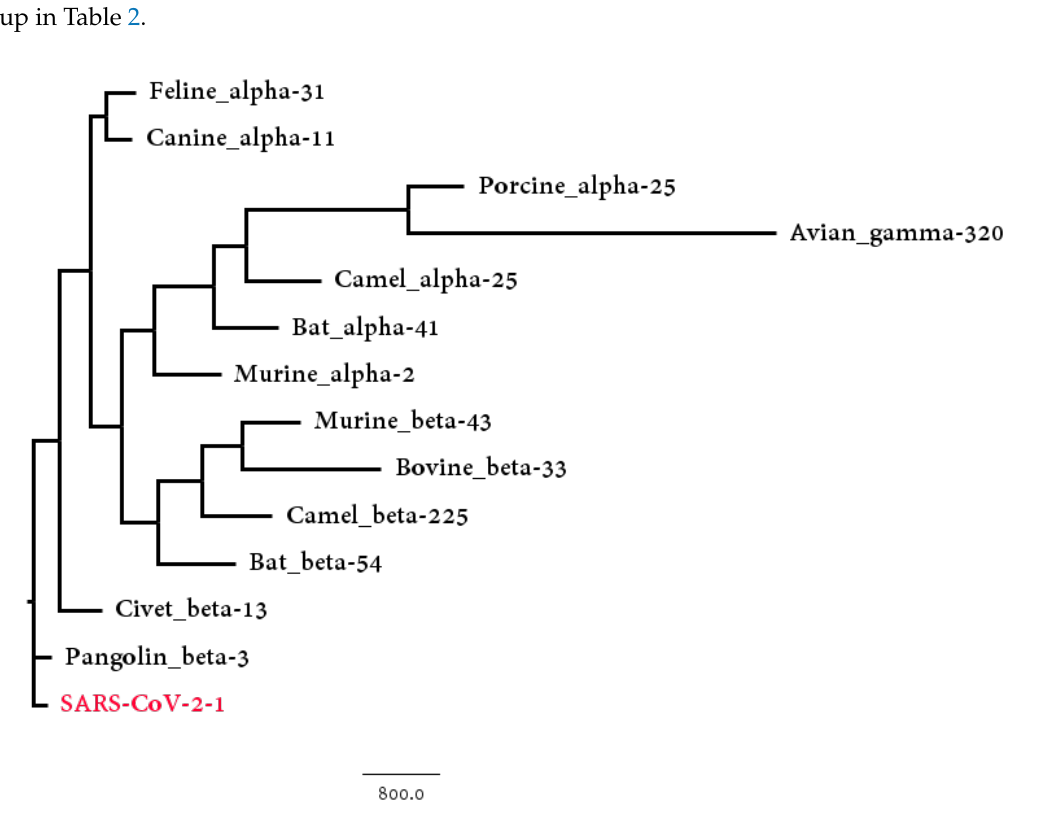
Figure 5. The phylogenetic BioNJ tree based on the Hausdorff distance between SARS-CoV-2 strains group and 13 possible host